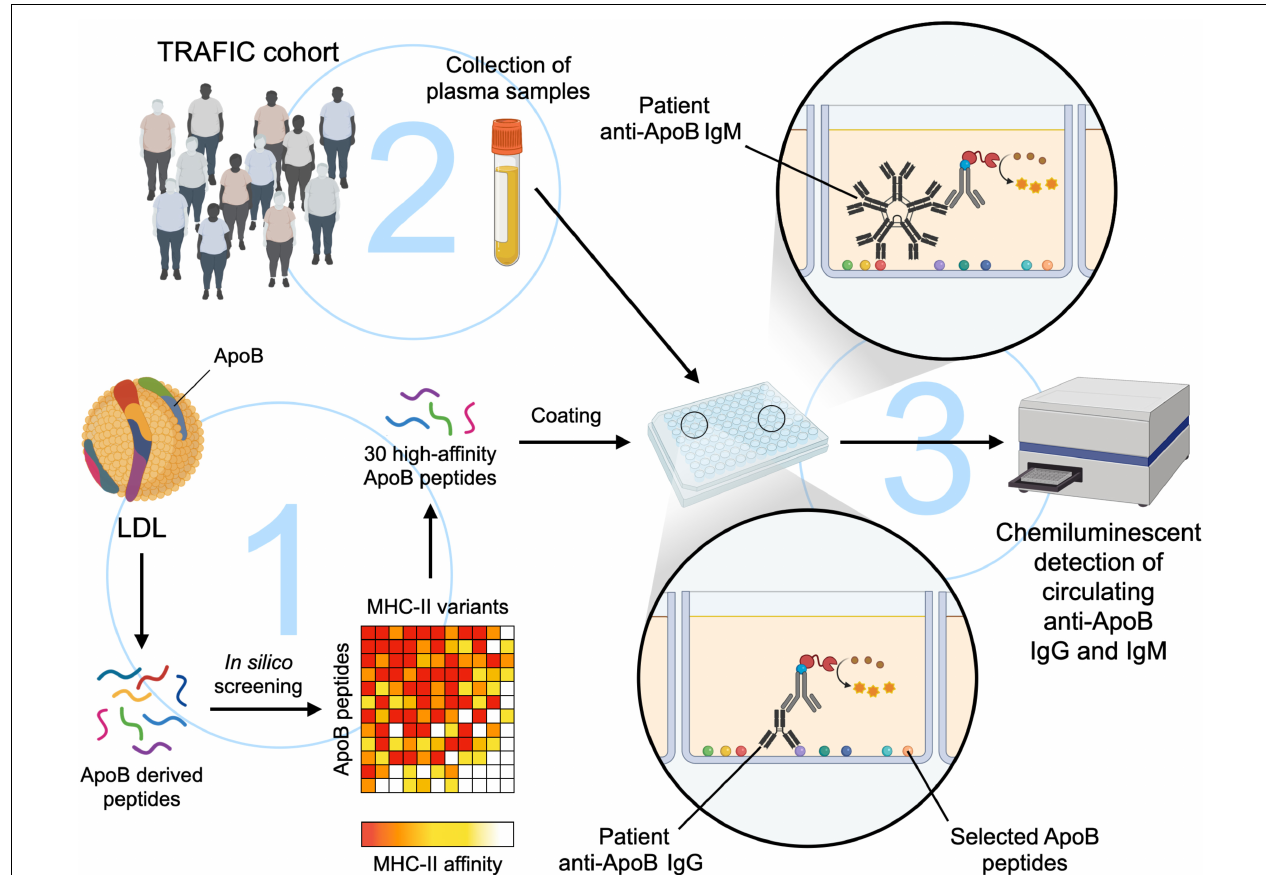
FIGURE 1 | Study workflow for the development of a novel ELISA to detect anti-ApoB IgG- and IgM- plasma levels. (1) ApoB-derived peptides with a length of 15 amino acids were screened in silico for their binding affinity to MHC-II variants (18). A pool of 30 peptides that showed a high affinity to MHC-II in direct in vitro affinity measurements were used to coat a microplate at 5 µ g/mL. (2) A total of 307 plasma samples from the TRAFIC cohort were analyzed by an in-house chemiluminescent ELISA (3) to detect circulating anti-ApoB IgG and IgM auto-antibodies. The figure was generated with schematics from